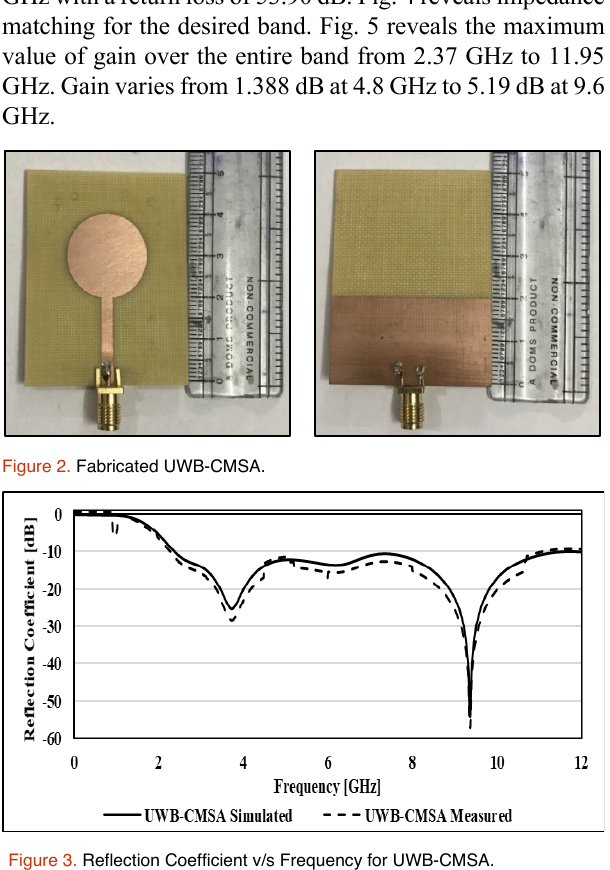
Figure 3. Reflection Coefficient v/s Frequency for UWB-CMSA.